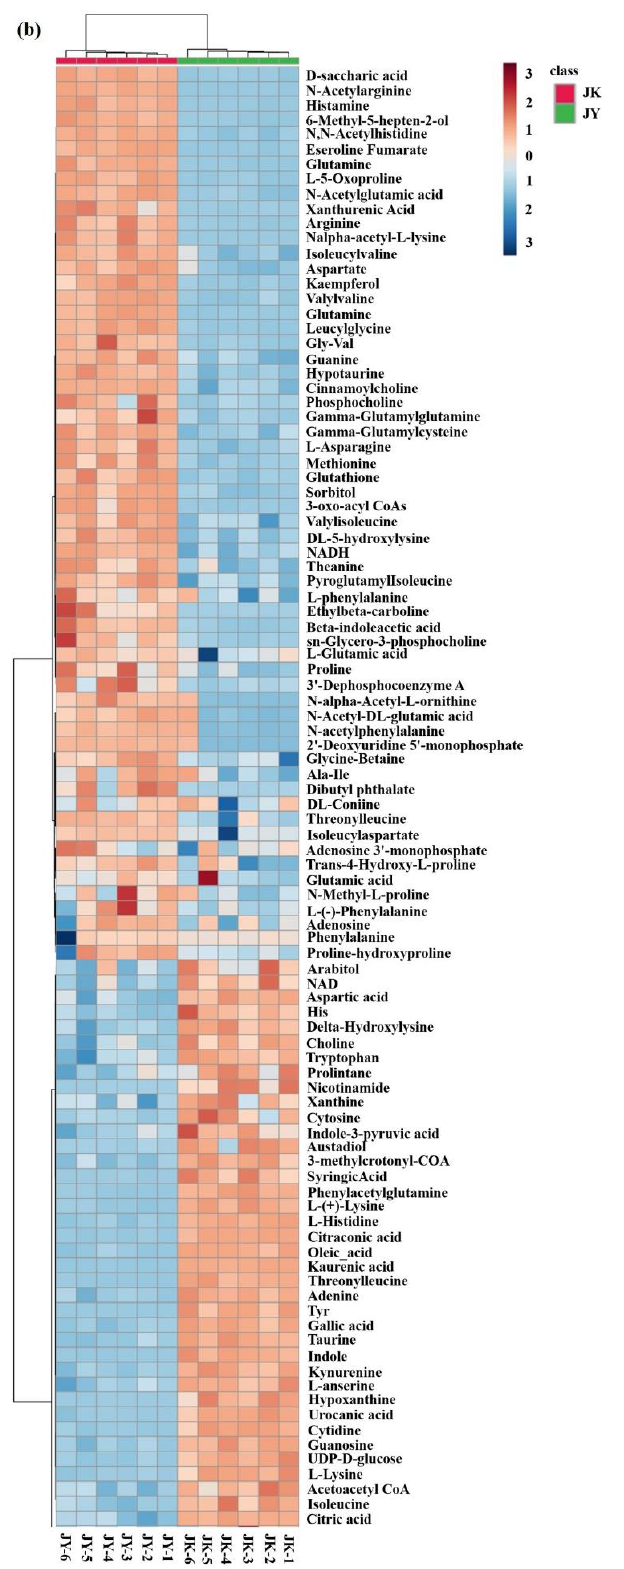
Figure 6. KEGG pathway analysis ( a ) and heat map ( b ) of the metabolites. The color represents the metabolite abundance (red: highest; blue: lowest).